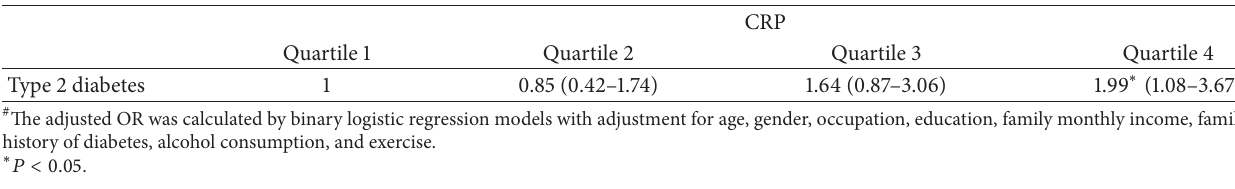
Table 3: The association between CRP and type 2 diabetes in 984 Chinese current smokers (OR; 95% CI) # .